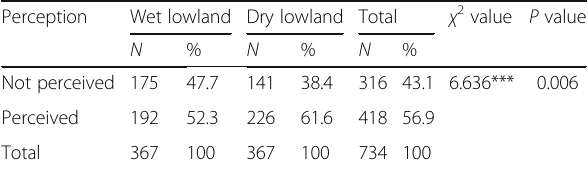
Table 1 Perception of climate change in the study area Perception